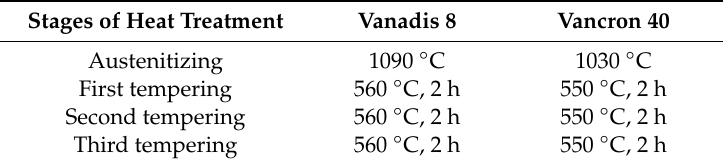
Table 2. Heat treatment parameters for Vanadis 8 and Vancron 40 tool